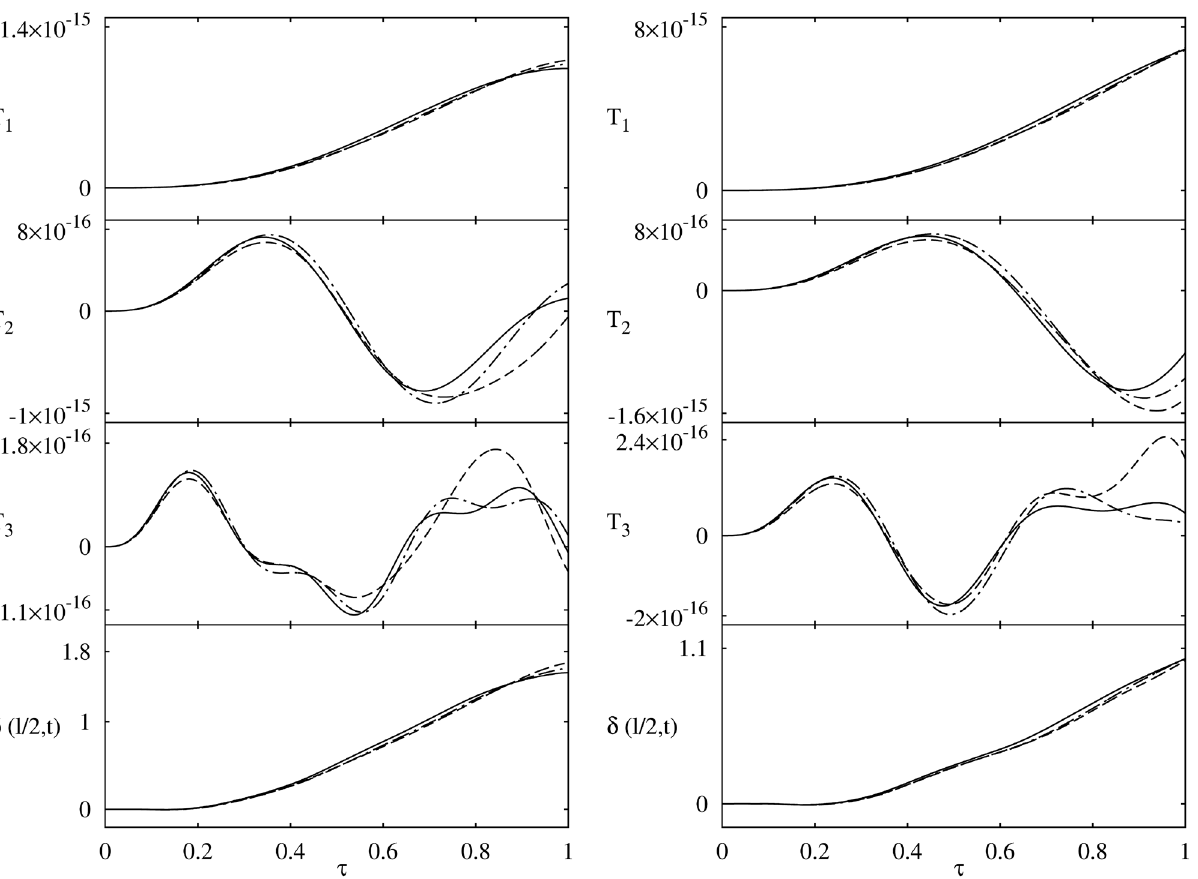
Figure 12 Time functions of the first three natural modes and relative deflections of nanotubes in resonance, l / d = 10, J = 0, α = 1, = 0, µ = 0, γ = 0.01, P / g = m d = 1.621·10 -15 nkg, gravity force; ____ k w i gravity and inertia force – harmonic response; _ _ _ gravity and inertia force – parametric response.